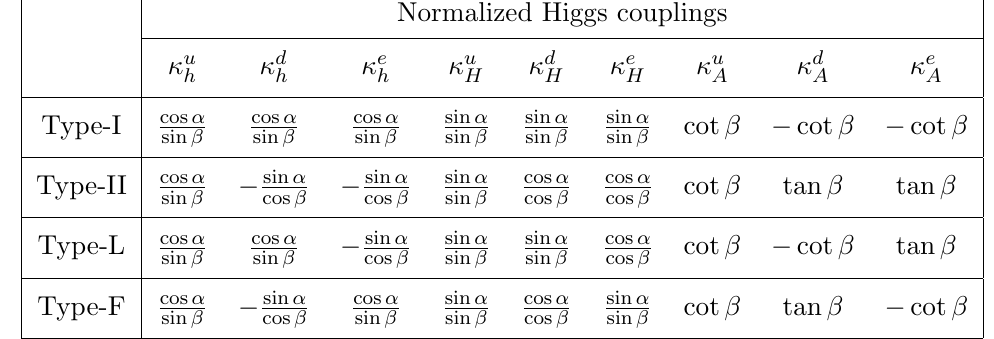
Table 2 . Higgs couplings to the SM fermions in the four di(cid:11)erent types of 2HDM, normalized to the corresponding SM